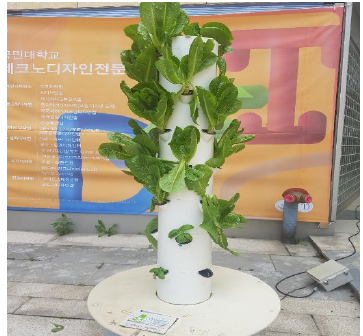
Figure 1. An artificial vegetable production system at the Kookmin University,